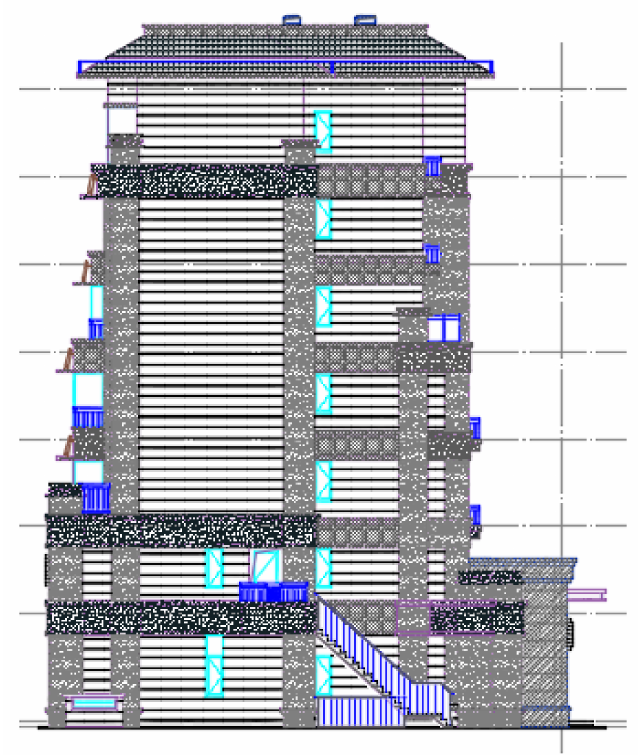
Figure 6. The facade update (view B).